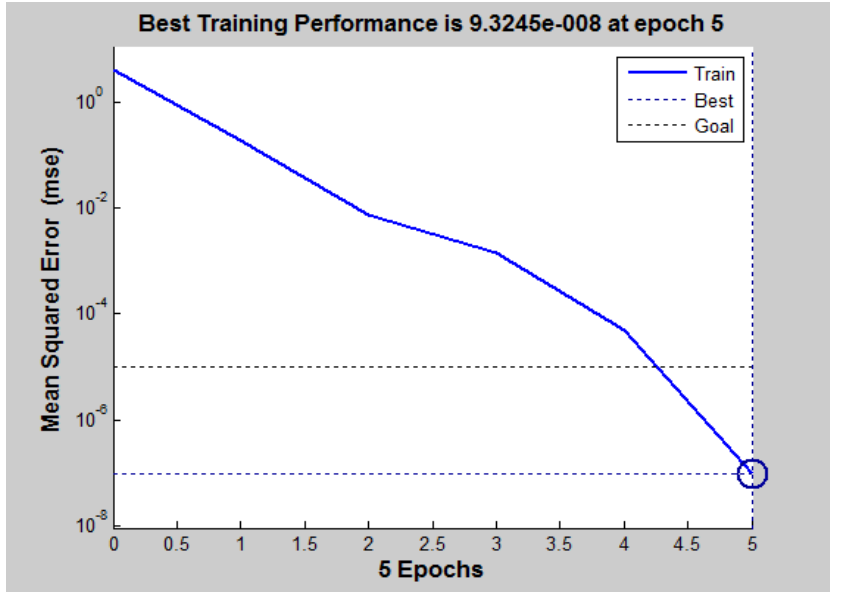
Figure 2. Training curve.